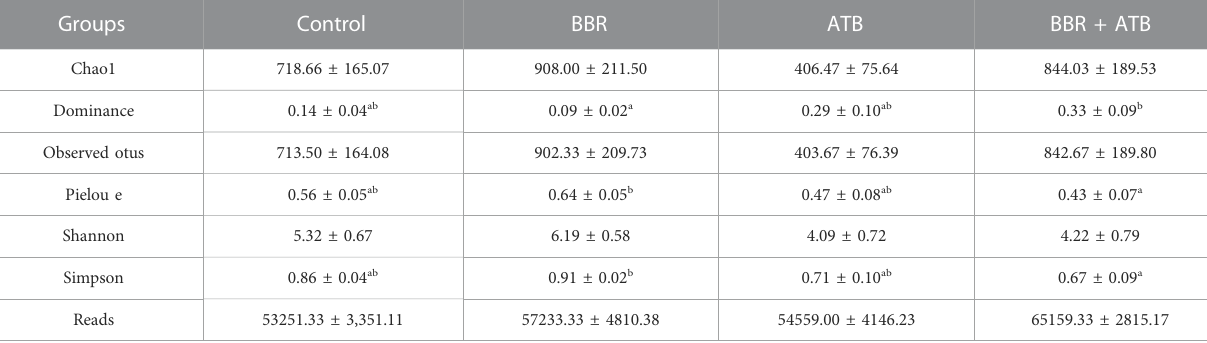
TABLE 5 Richness and diversity index of bacteria in the samples at 97% similarity level.